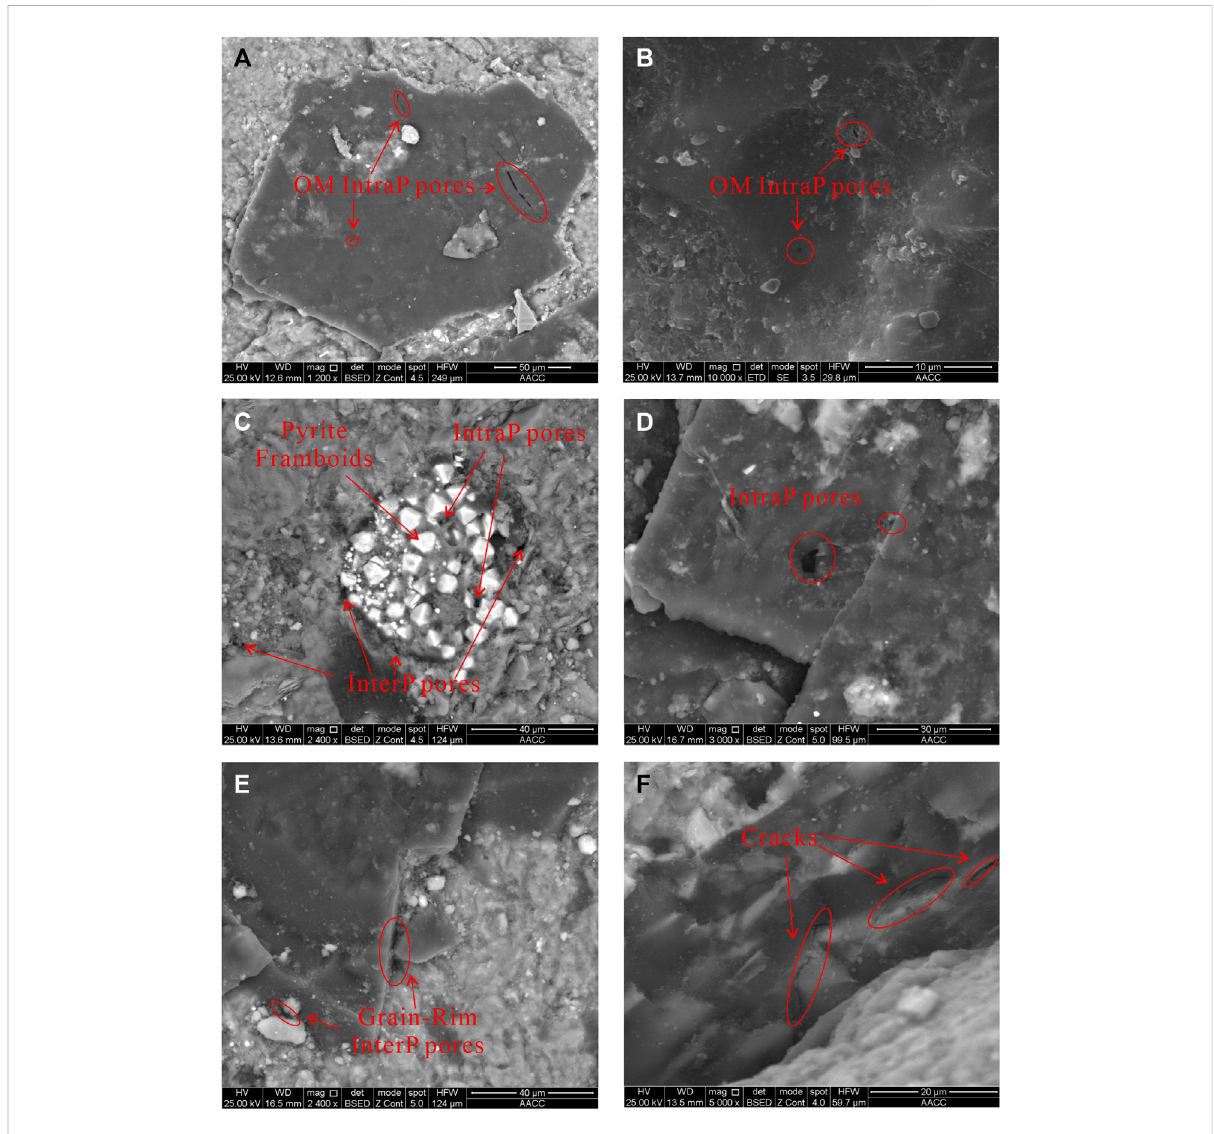
Frontiers in Earth